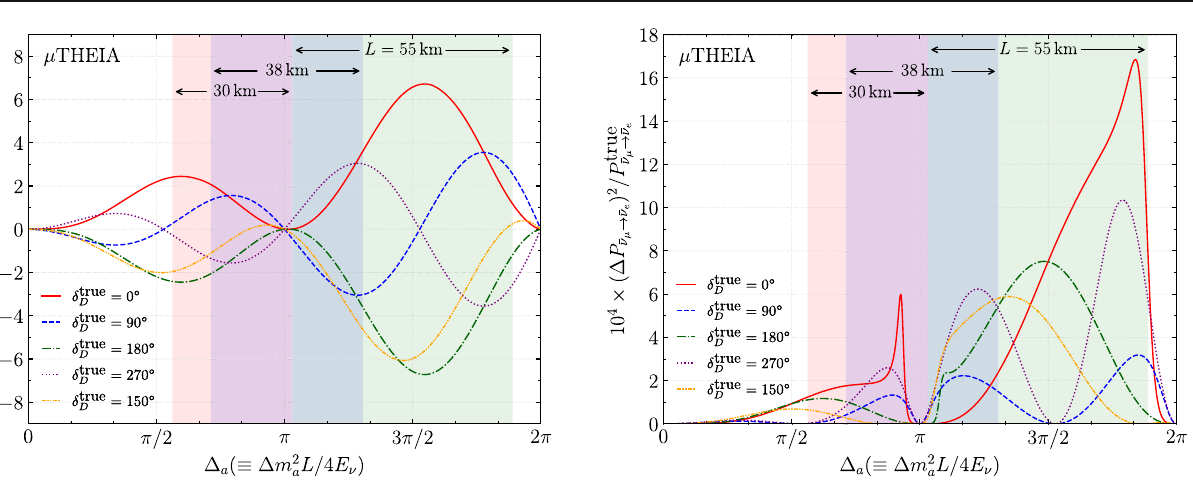
Fig. 13 Left: The oscillation probability difference (cid:8) P ¯ ν μ →¯ ν between 10 ◦ larger than the corresponding δ true e varies within [30, 55]MeV while the baseline is fixed at three different ) and fitting ( δ fit ) CP values as a function of the atmo- the true ( δ true D D baselines, L = 30km (red region), 38km (purple region), and 55km spheric oscillation phase (cid:8) a ≡ (cid:8) m 2 a L / 4 E . Five different true CP val- (lightgreenregion).Right:Therelativedifference ((cid:8) P ¯ ν μ →¯ ν = 0 ◦ (red), 90 ◦ (blue), 180 ◦ (green), 270 ◦ (purple), and 150 ◦ ues δ true D with the same (orange) are shown for comparison. The fitting values δ fit are assigned D